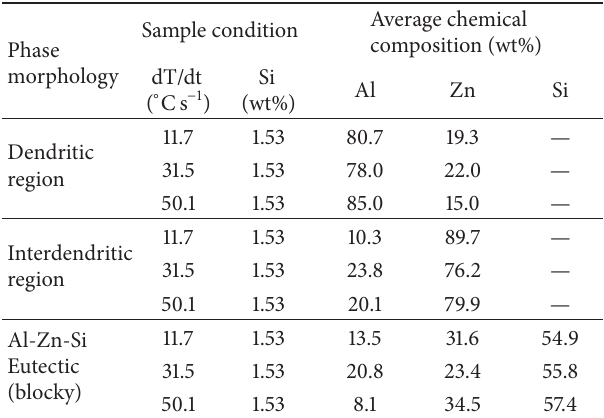
Table 2: EDXS microanalysis of the Al-Zn-1.5Si (wt%) modified alloy solidified at different cooling